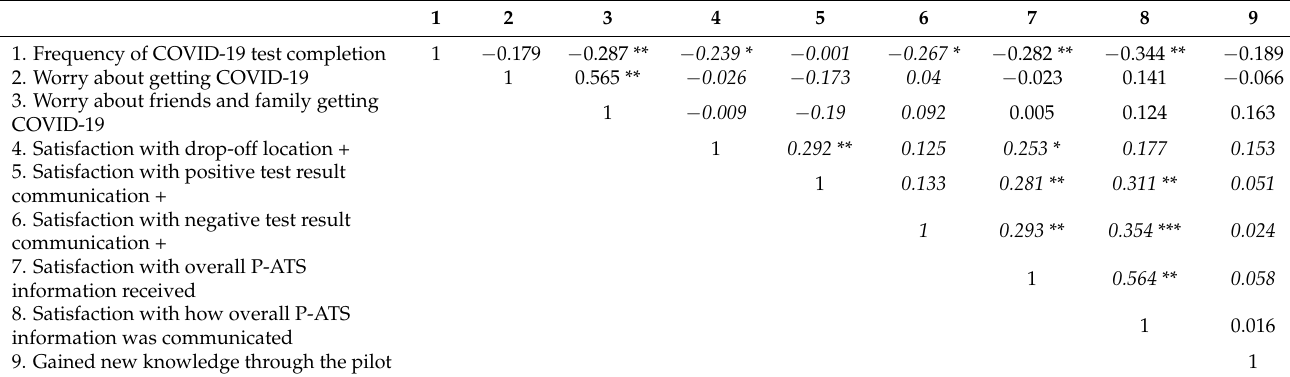
Table 6. Correlation matrix of frequency of PCR test completion (combined swab/saliva), mental health, and programme satisfaction ( n = 91).